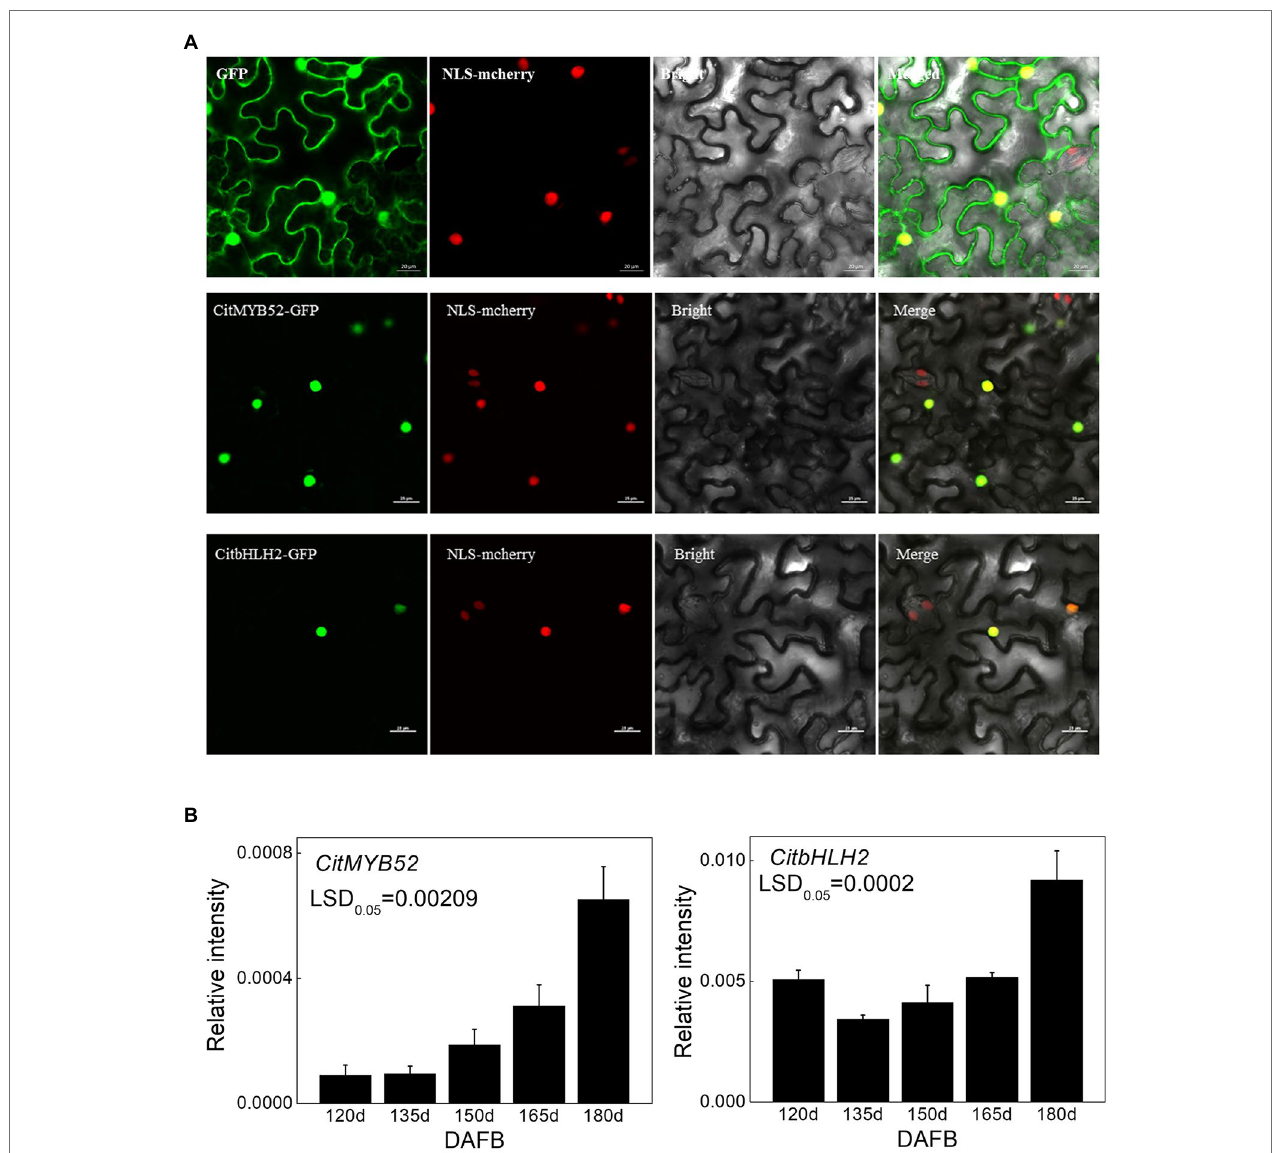
FIGURE 4 | Characterization of CitMYB52 and CitbHLH2. (A) Subcellular localization analysis was performed in N. benthamiana leaves stably transformed with a red nuclear localization marker. GFP fluorescence of CitMYB52-GFP and CitbHLH2-GFP are indicated. The empty vector control is at the top. Bars = 25 μ m. (B) Expression of the CitMYB52 and CitbHLH2 genes in the flesh of “Ponkan” fruits during the late stage of fruit development, DAFB, days after full blossom. Error bars represent SE ( n =